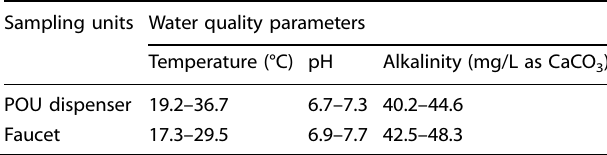
Table 1. Water quality parameters of samples.